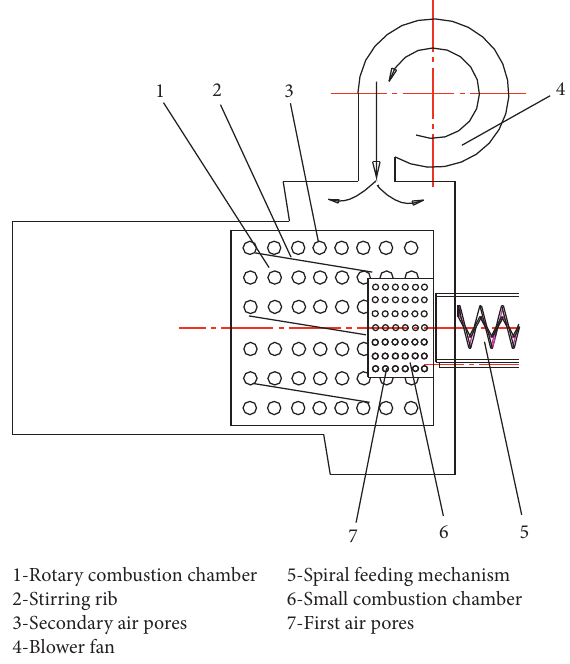
Figure 1: Schematic of biomass pellet rotary